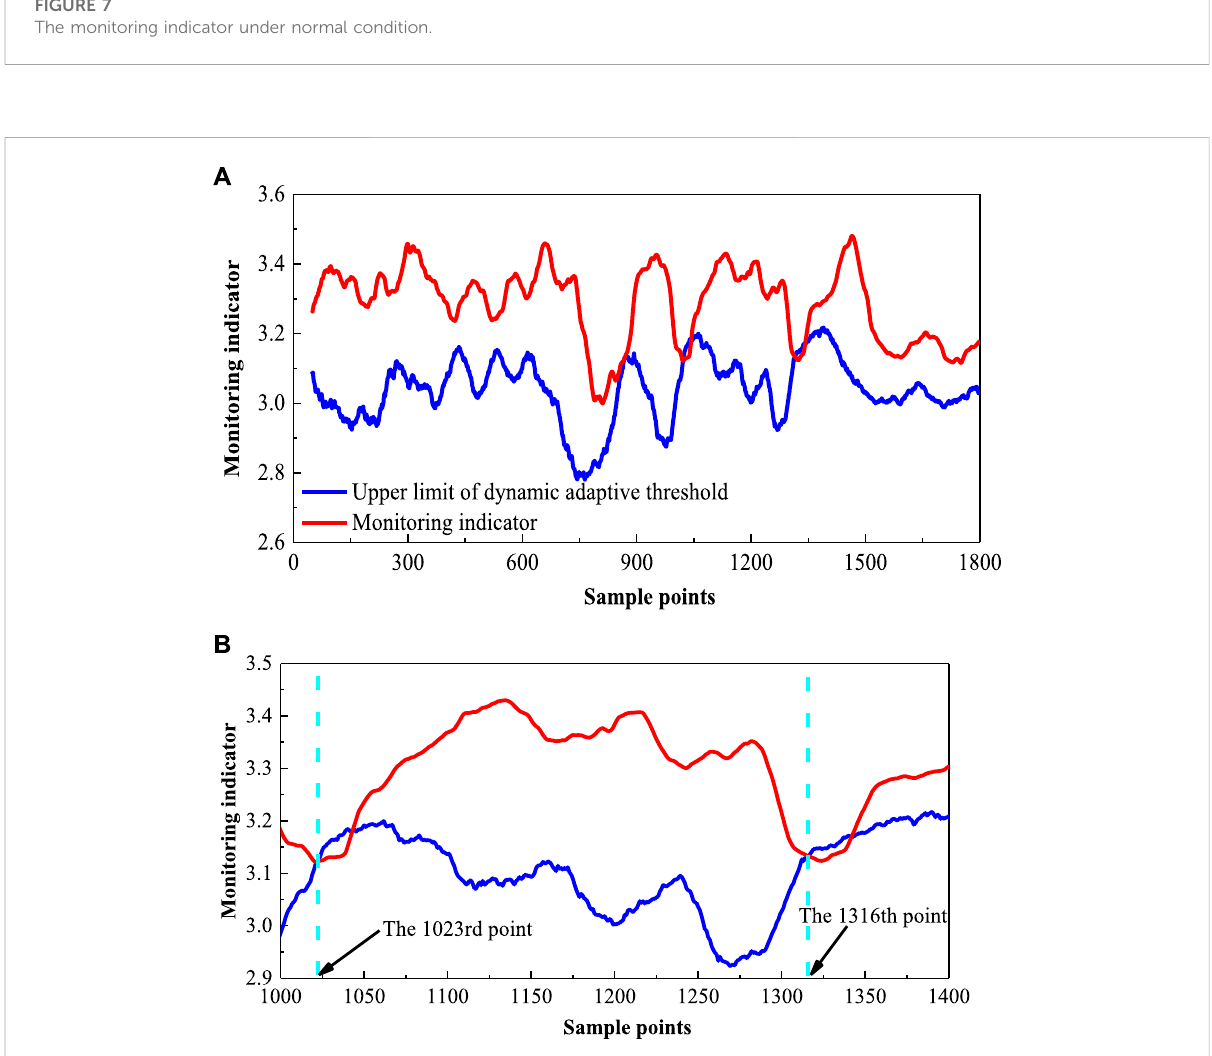
FIGURE 8 The results of early fault warning based on LSTM-SDAE (A) early fault warning result (B) enlarged view from the 1000th to the 1400th sample